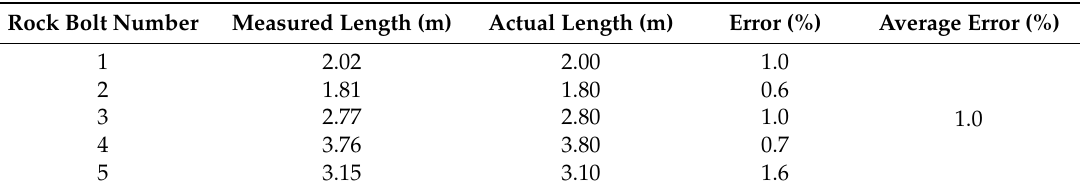
Table 2. The results for five of the chosen rock bolts at Yangqu Hydropower Station.